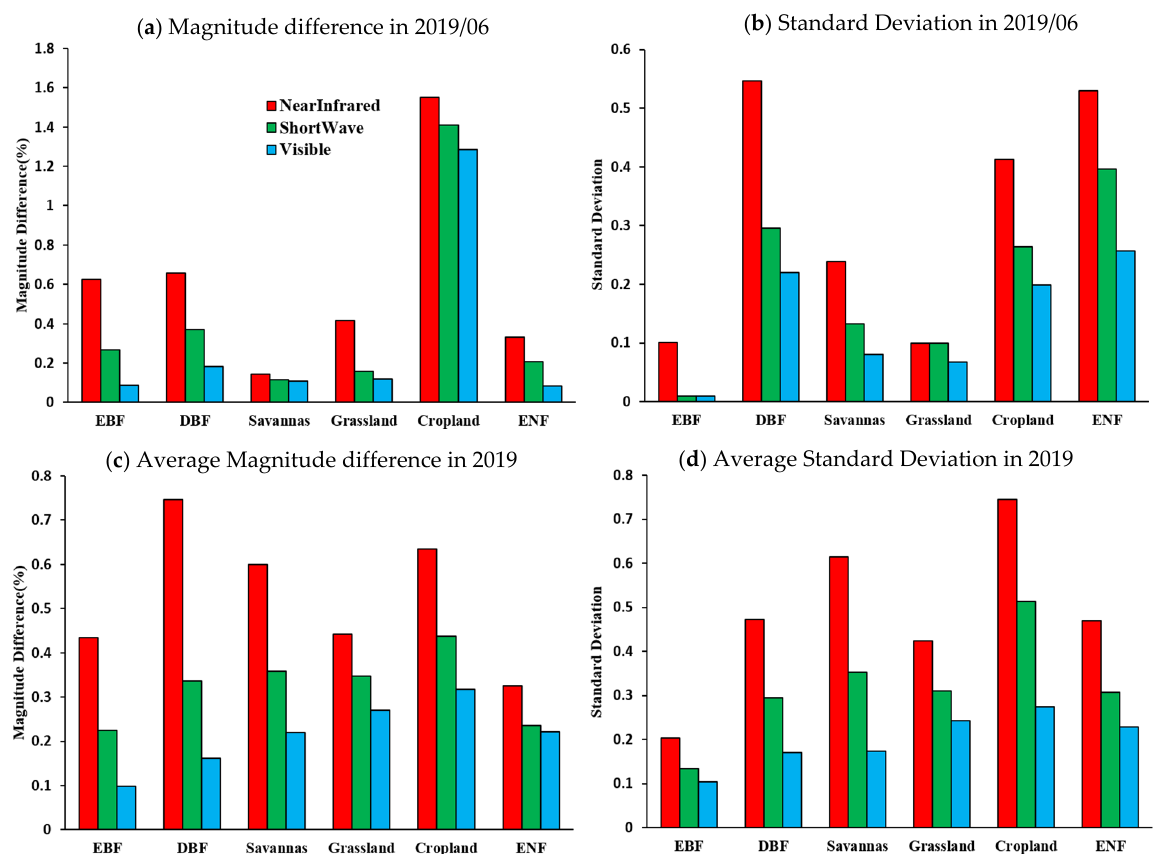
Figure 9. Statistics of magnitude difference and standard deviation of BRDF principal planes due to BRDF temporal smoothing in 2019/06 ( a , b ) and their annual average level for each study site ( c , d ).